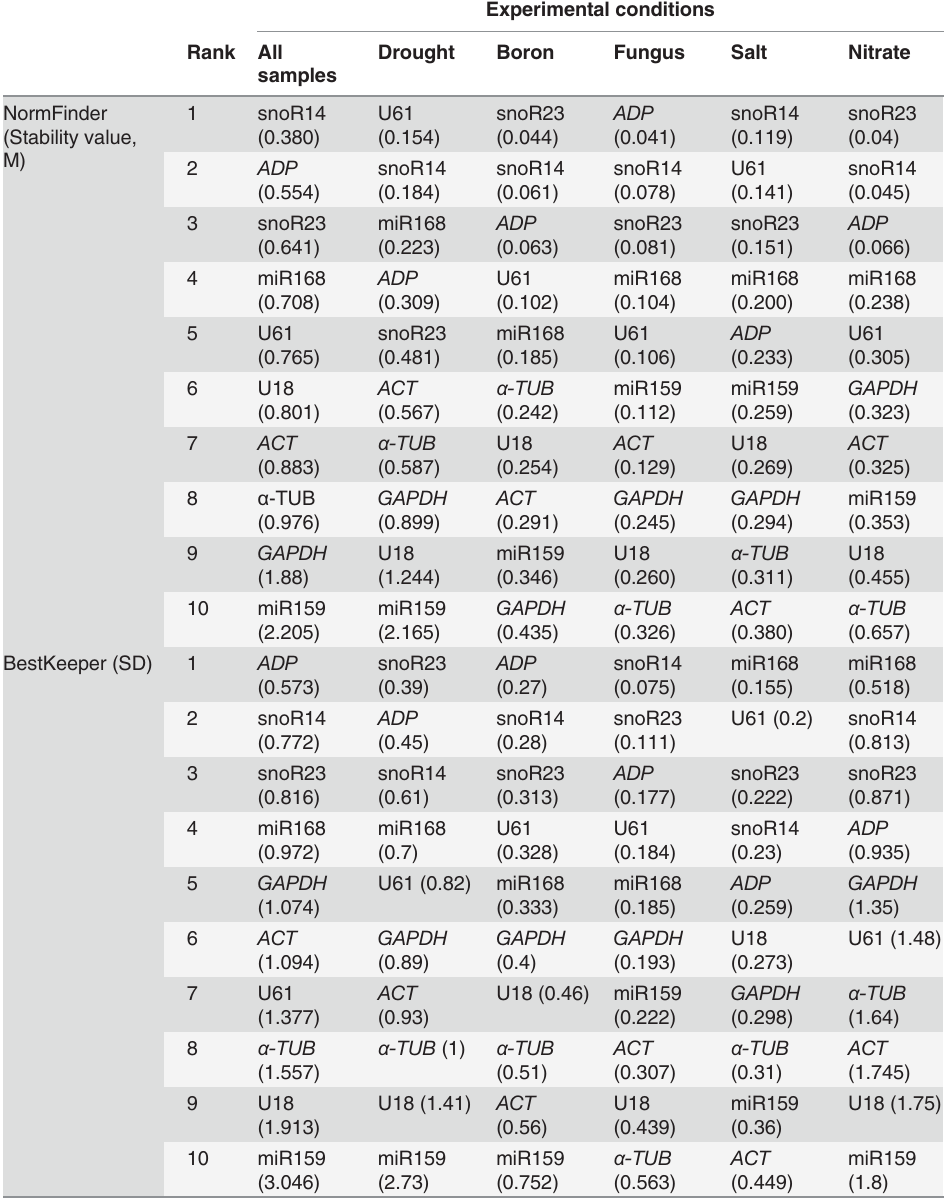
Table 2. Expression stability ranking of candidate reference genes as calculated by NormFinder and